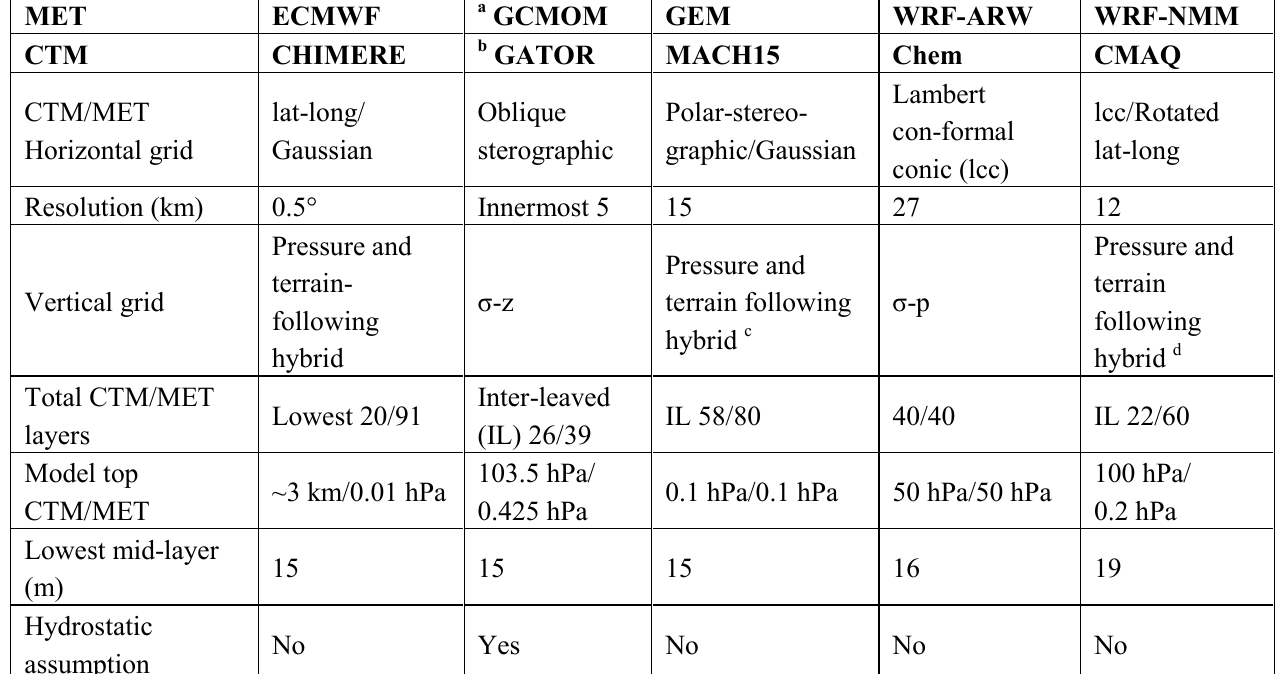
Table 1. Basic model configurations which have a primary impact on the parameterization of physical processes within the Planetary Boundary Layer (PBL) of five coupled continental-scaled meteorological (MET) and Chemistry Transport Models (CTM) used for air quality